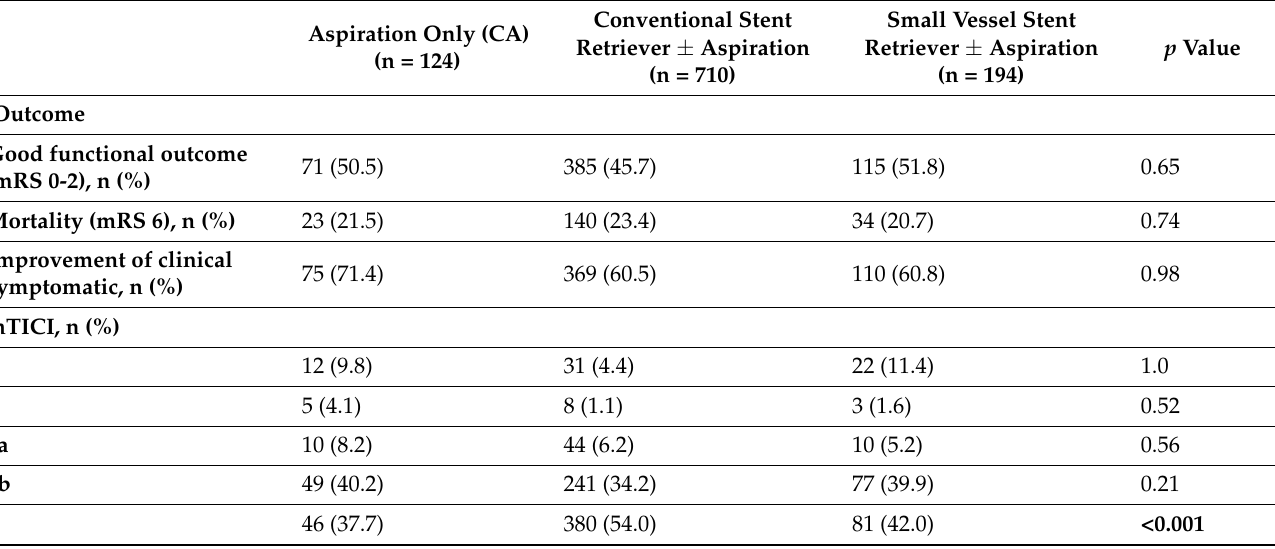
Table 4. Sub-analysis MCA-M2 occlusions, outcomes at 90 days, procedural results, and safety